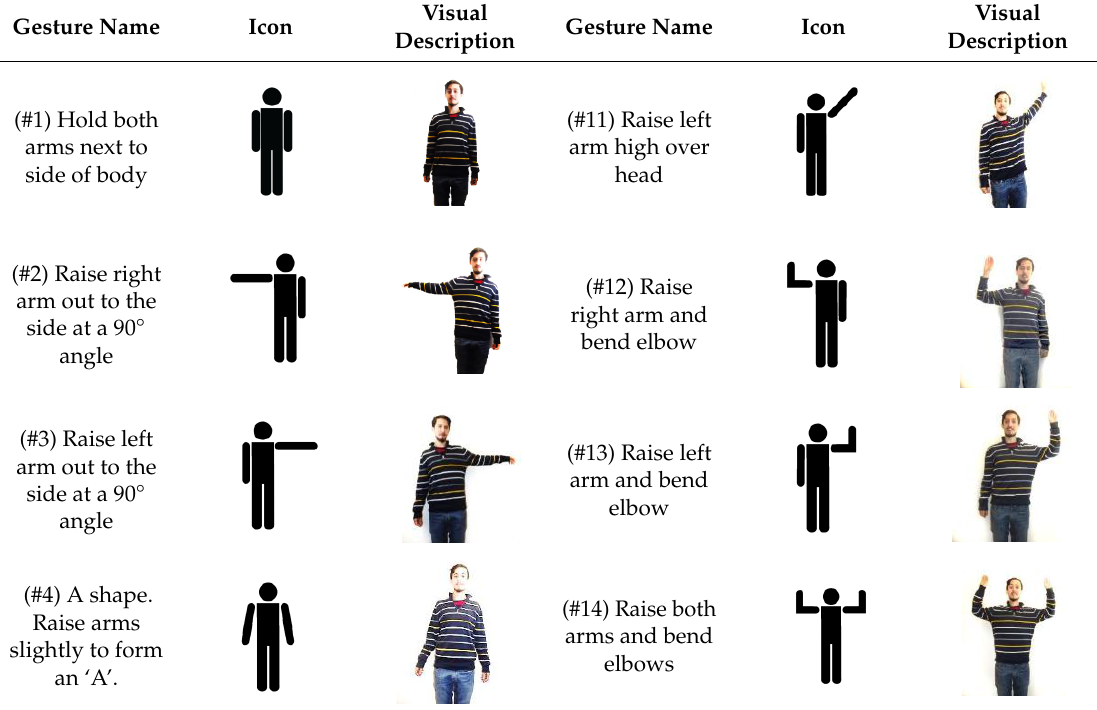
Table 1. Physical gestures selected to study the User Interface (UI).